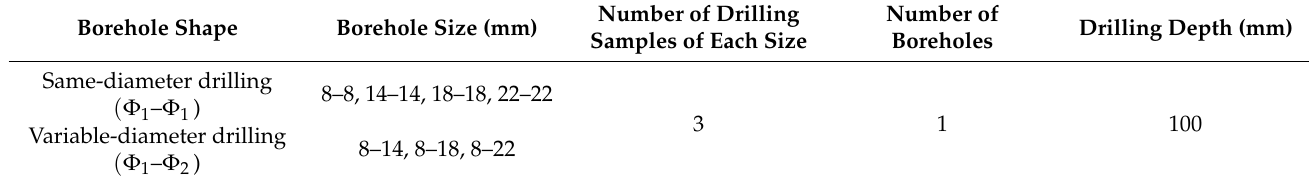
Figure 1. Schematic diagram of the test sample. Figure 2. Schematic diagram of split mold.